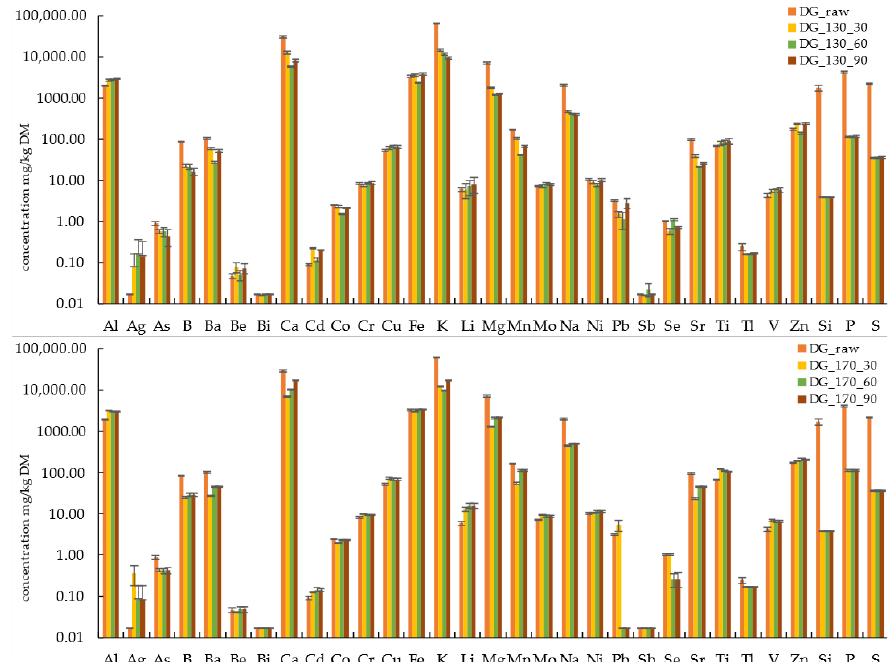
Figure 10. Dry matter (DM) based on mean values ± standard deviations of different elements for raw materials and solids provided by hydrothermal treatment of the digestate (DG) at 130 and 170 °C with 30, 60 and 90 min holding times. Numerical values can be found in Appendix A.